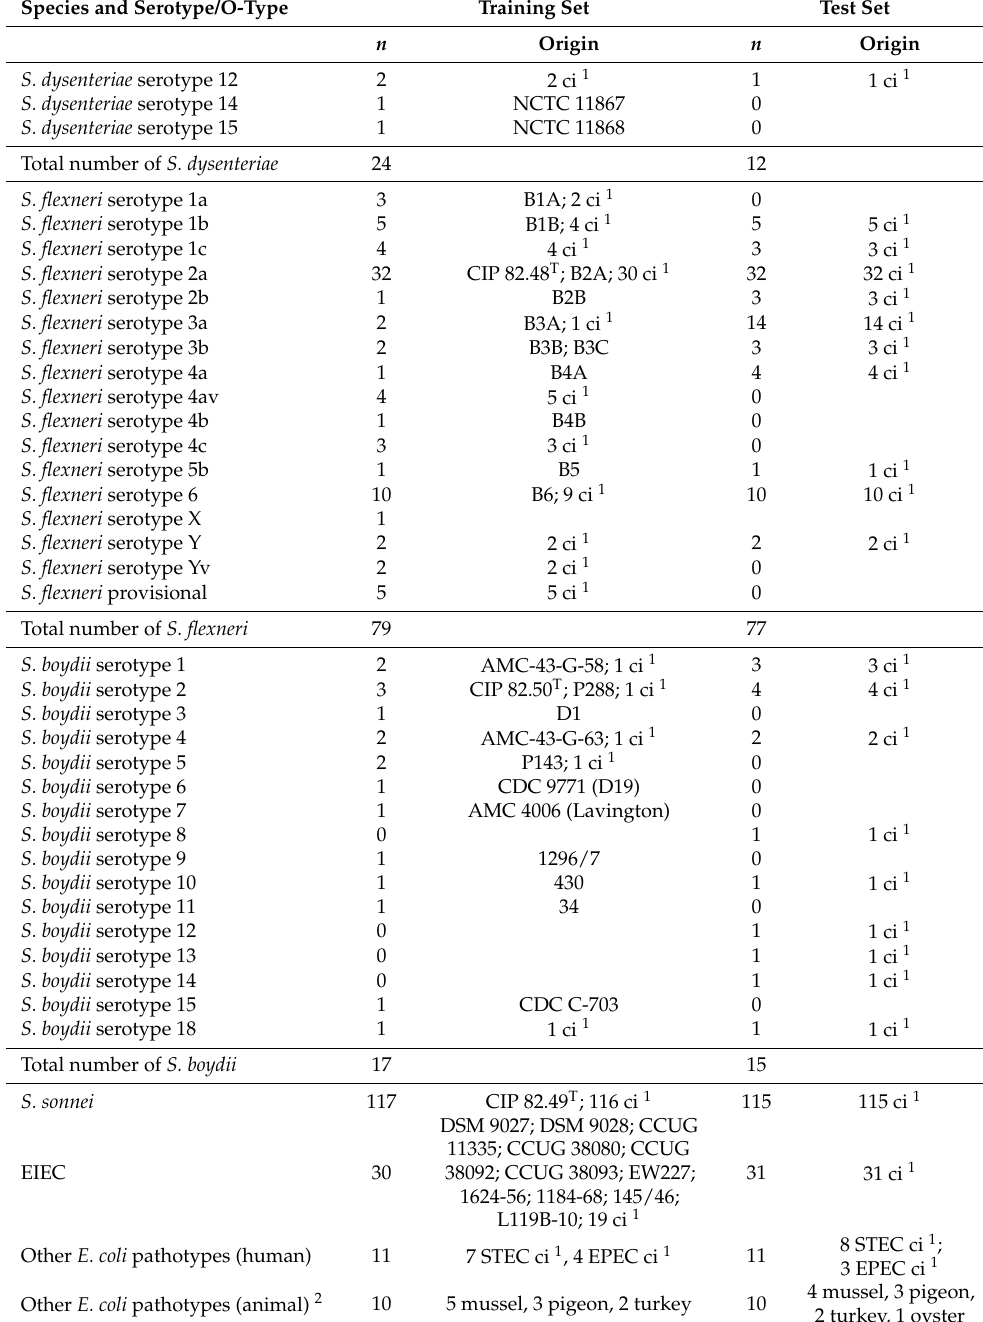
Table 1. Cont. Species and